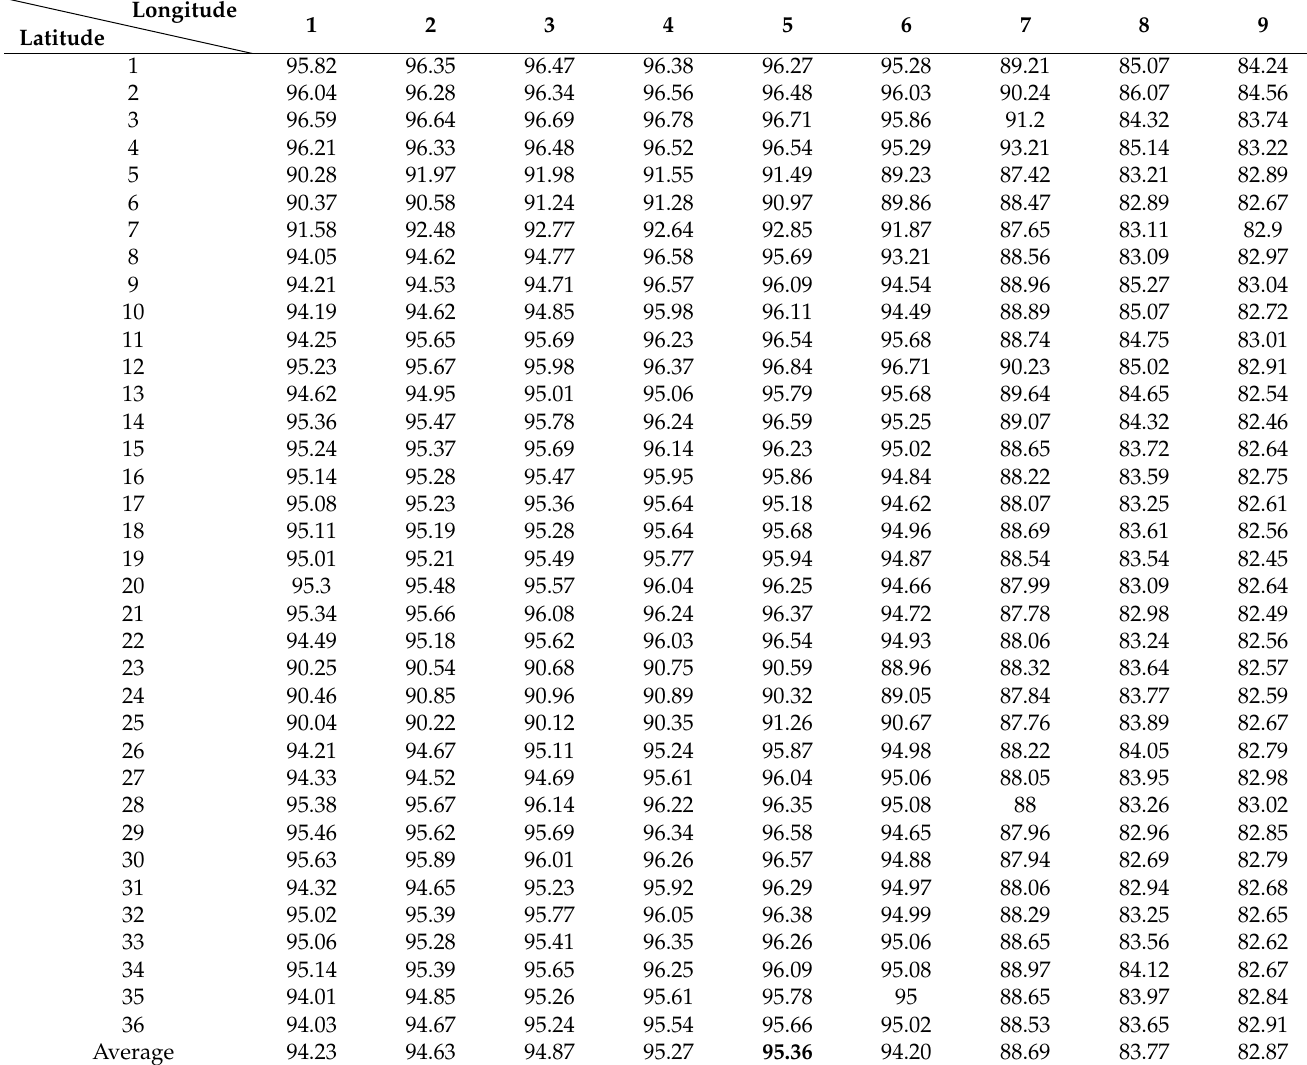
Table 1. Recognition with different starting points with 3 viewing